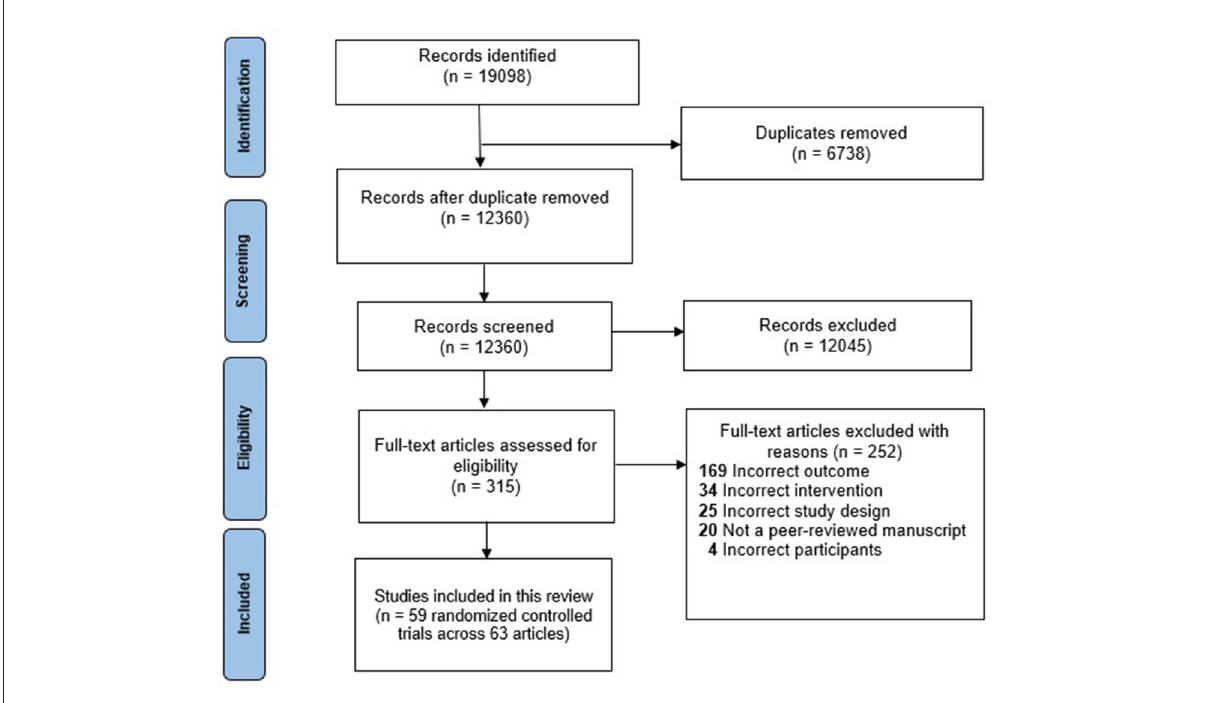
FIGURE1 Flow diagram of included